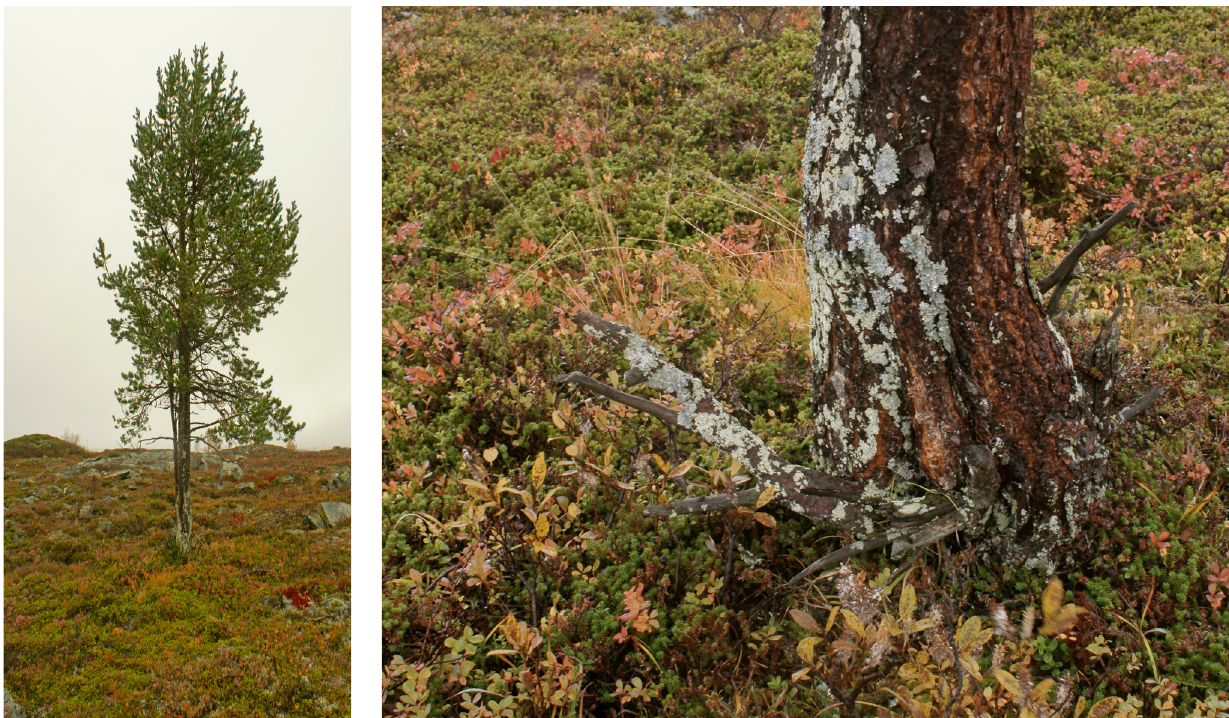
Figure 27: Left. The pine treeline has advanced by 190 m in elevation since the early 20th century at this locality. This pine germinated in an exposed snow poor dwarf-shrub heath by the late 1930s. Right. Multiple branching at the trunk base de- monstrates that this pine suffered repeated dieback during the sapling state. Mt. Solberget, 690 m a.s.l. 25 September